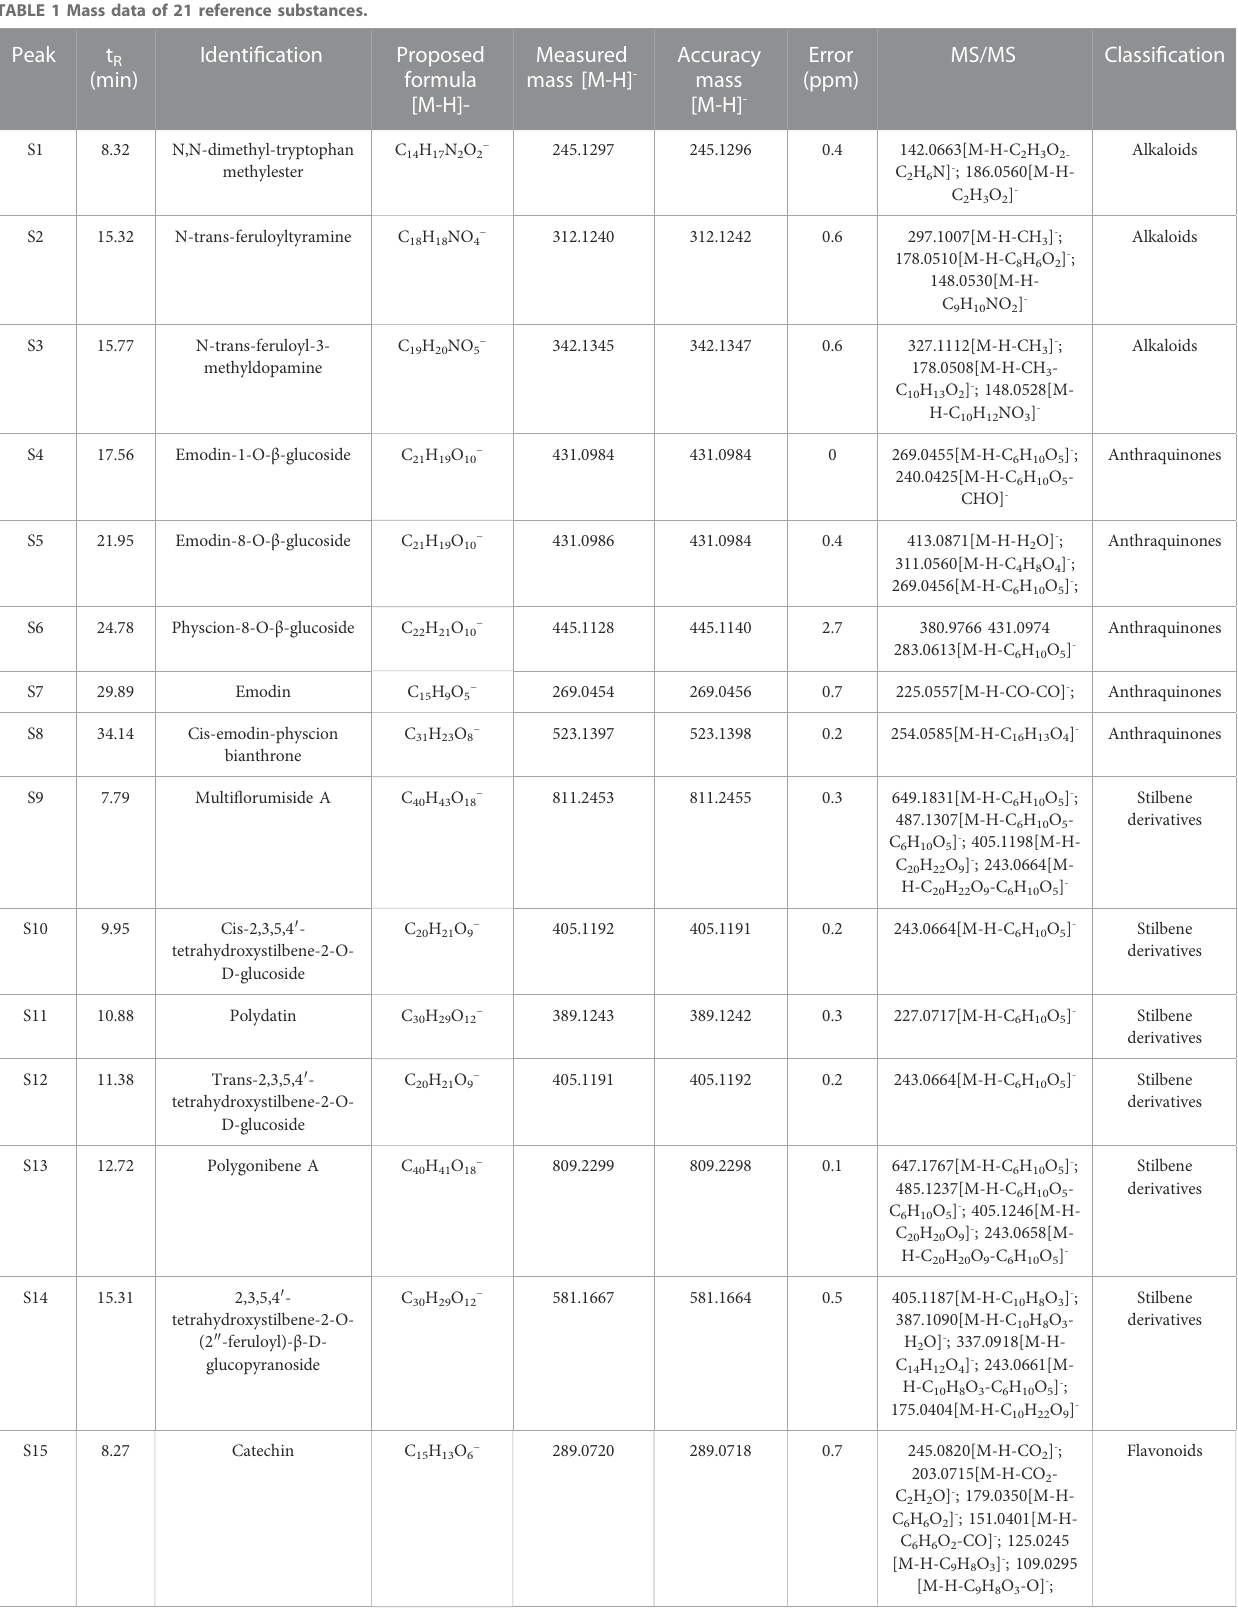
TABLE 1 Mass data of 21 reference substances.